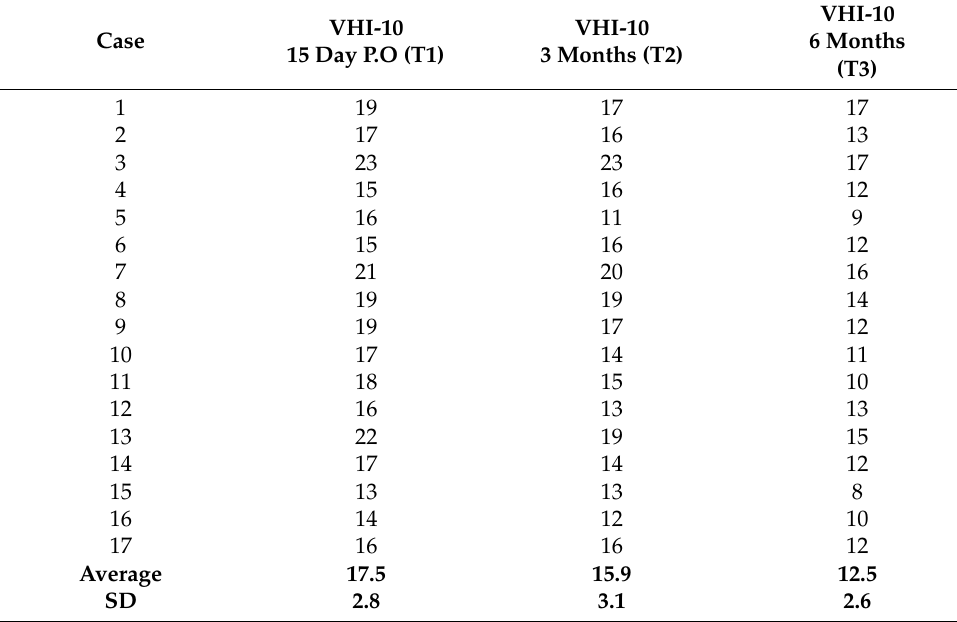
Table 4. Phonation outcomes evaluated by VHI-10 of each patient.